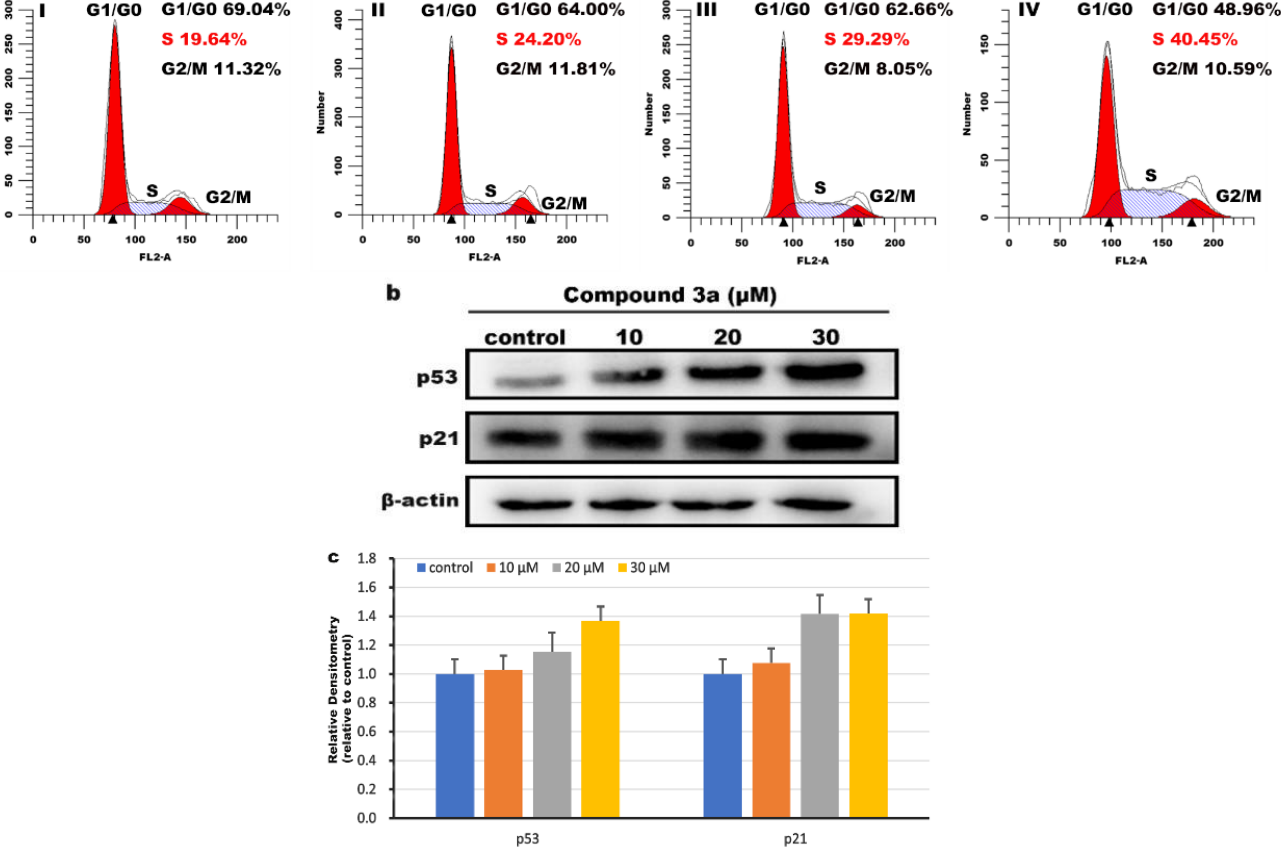
Figure 4. ( a ) Distribution of cell cycle of HeLa cells incubated with different concentrations of compound 3a (control ( I ), 10 µ M ( II ), 20 µ M ( III ), and 30 µ M ( IV )) for 24 h. ( b ) Western blotting analysis of p53 and p21 proteins in HeLa cells treated with different concentrations of compound 3a for 24 h. β-actin was used as the internal control. ( c ) Quantitative analysis of p53 and p21 protein expres- sion.